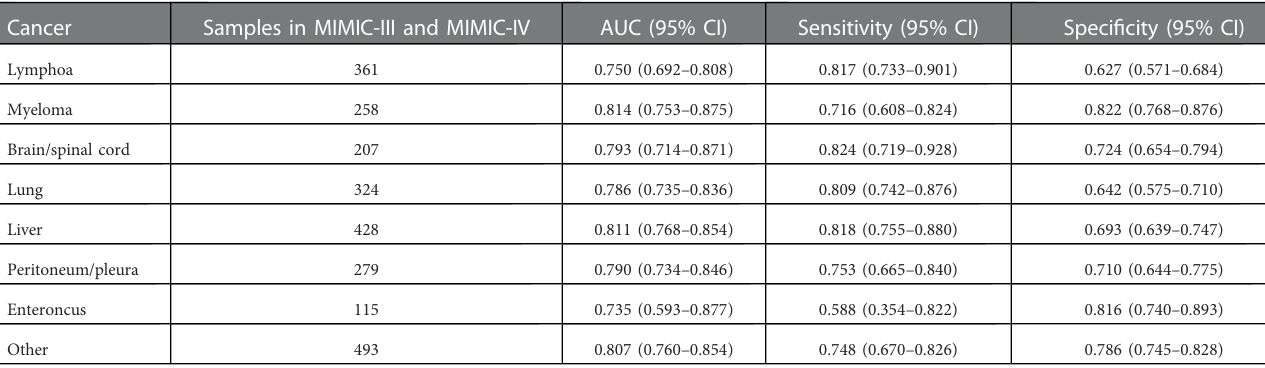
TABLE 4 Evaluation of the prediction value of the model in different cancers. Cancer Samples in MIMIC-III and